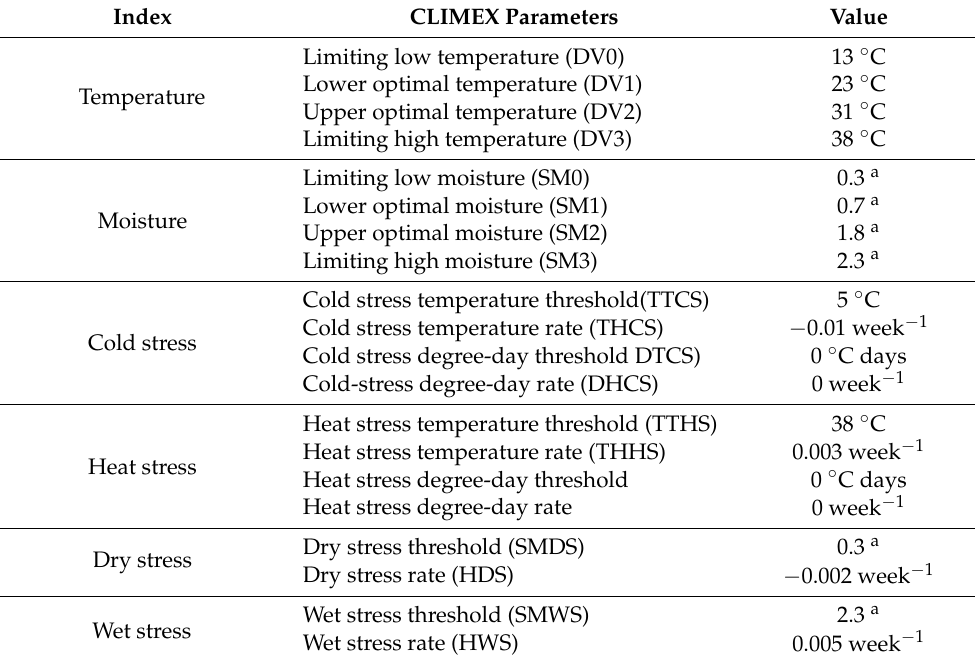
Table 2. The indices and parameters used in the development of the CLIMEX model for Acaciothrips ebneri based on its native range